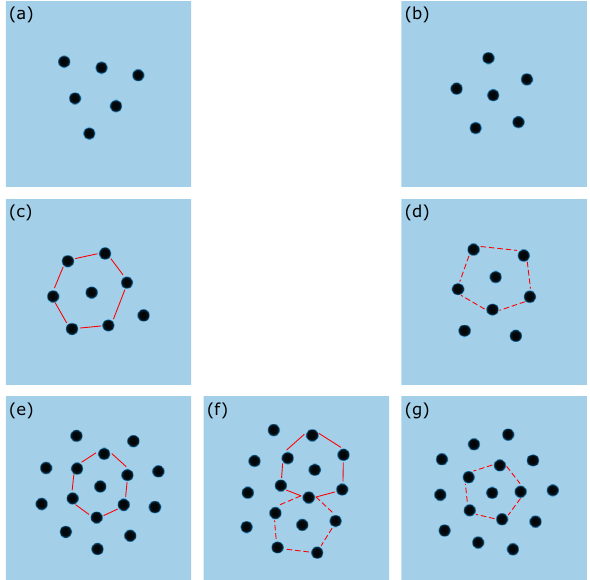
Figure 1. Experimental pictures of magnetocapillary self-assemblies’ typical equilibrium states. These 6 . ( c , d ) Two assemblies are made of a finite number N of particles. ( a , b ) Two coexisting states for N = 8 . ( e – g ) Three coexisting states for N 16 . Pictures on the left column ( a , c , e ) show coexisting states for N = = that central particles tend to form a triangular lattice, while pictures of the right column ( b , d , g ) show central particles having a five-fold symmetry. Picture ( f ) shows a combination of beads with 5 or 6 neighbors in the center of the